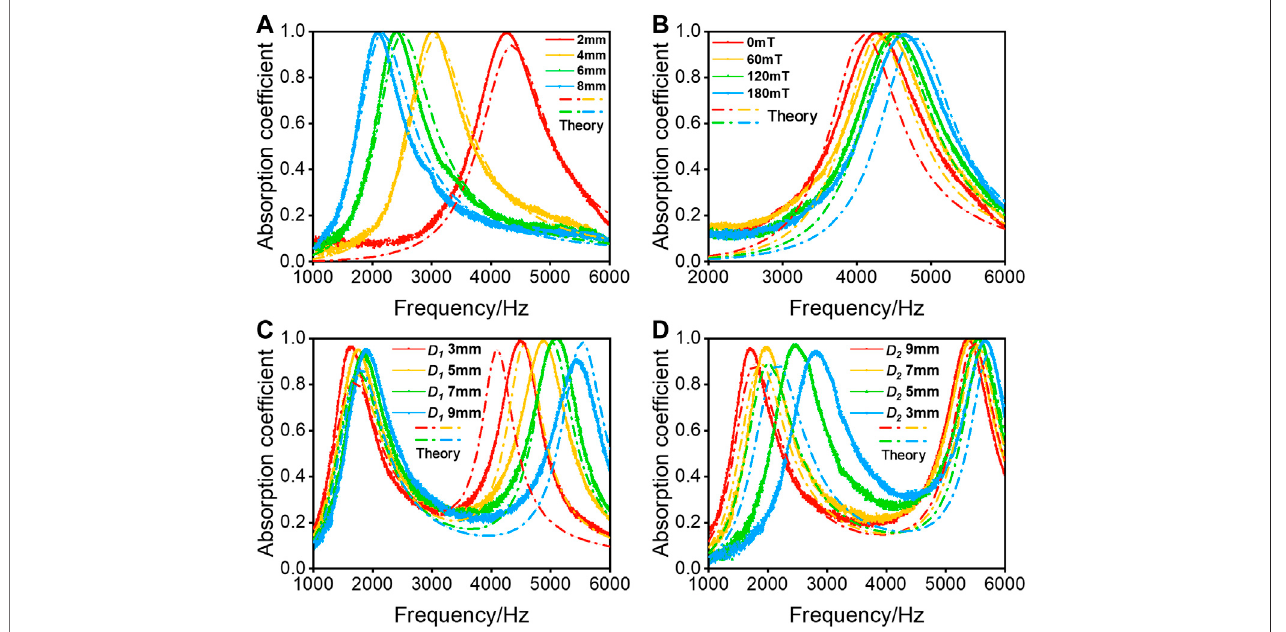
FIGURE 7 | Comparison of experimental and numerical results: the air cavities length (A) , the magnetic fi eld (B) , the length of the front cavity of double-layer membrane structure (C) , the length of the back cavity of double-layer membrane structure (D) .